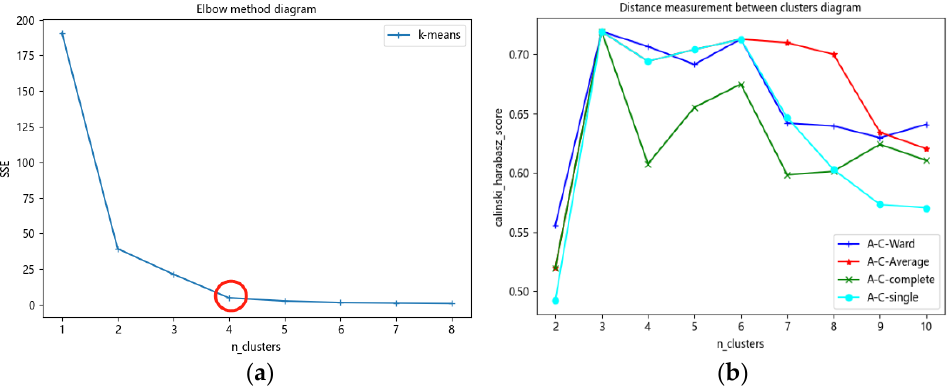
Figure 4. ( a ) Elbow method to determine the optimal number of clusters; ( b ) Silhouette coefficient assessment inter ‐ class metric approach.